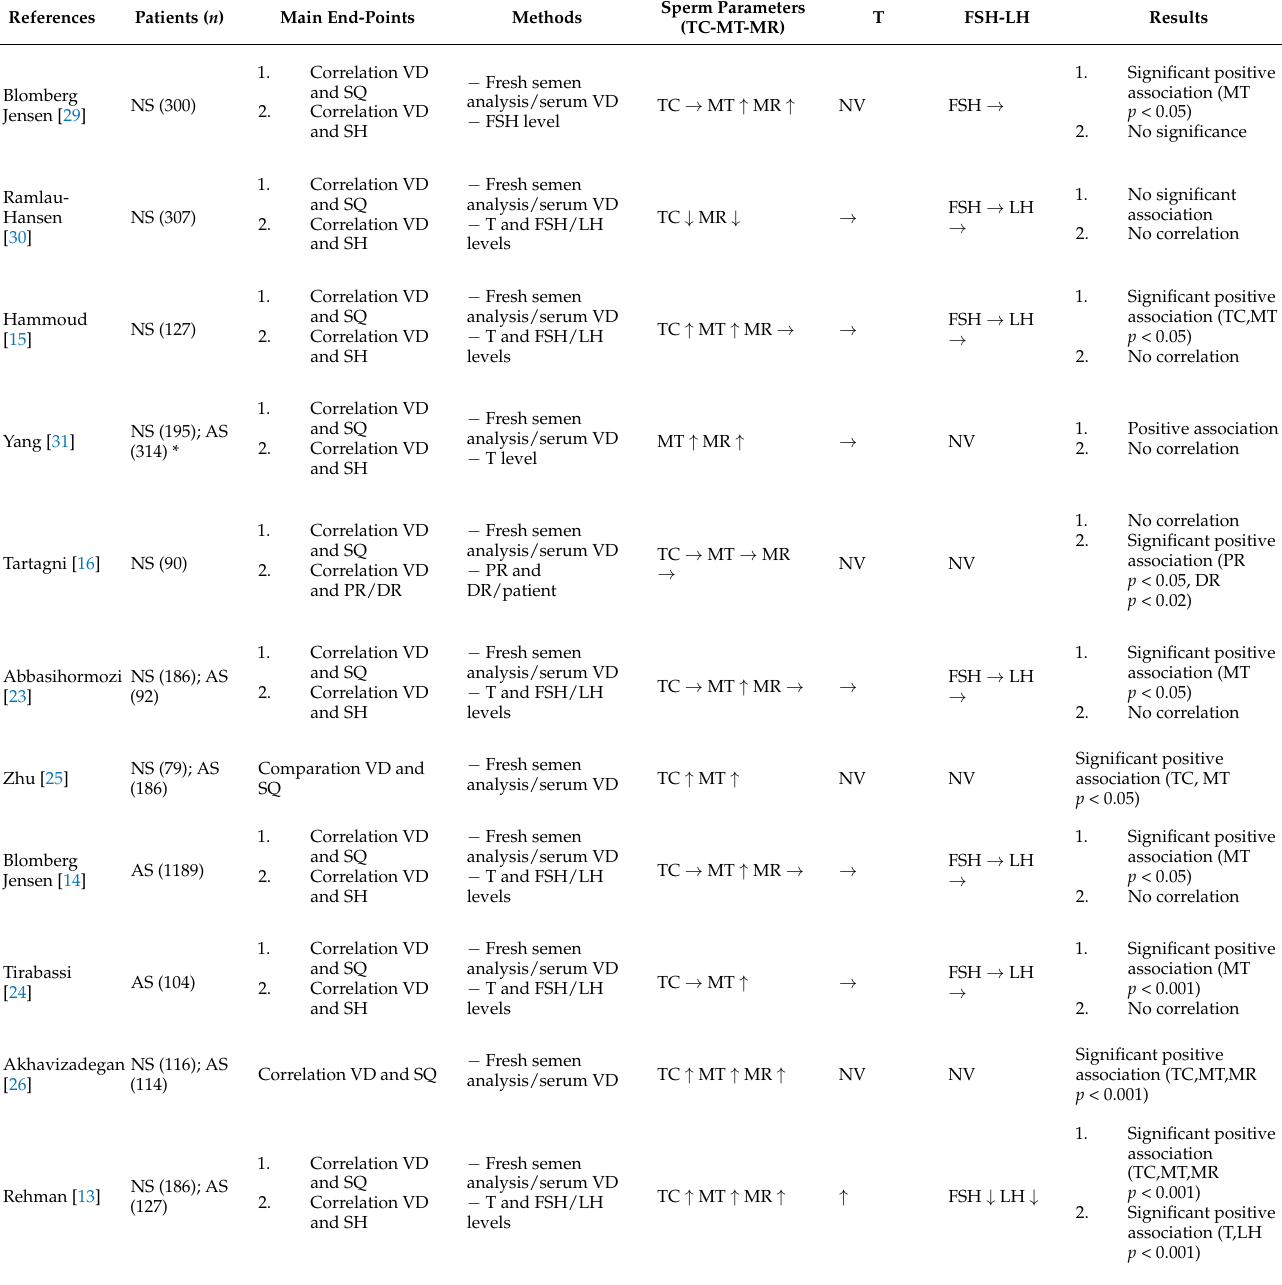
Table 2. Main results on correlation between VD serum level with semen parameters and male sex steroid hormone